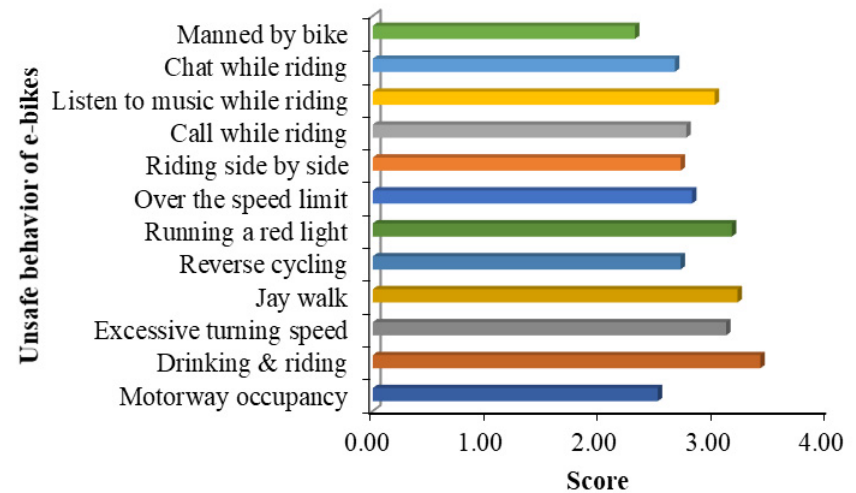
Figure 3. Evaluation of unsafe behavior of e-bikes.